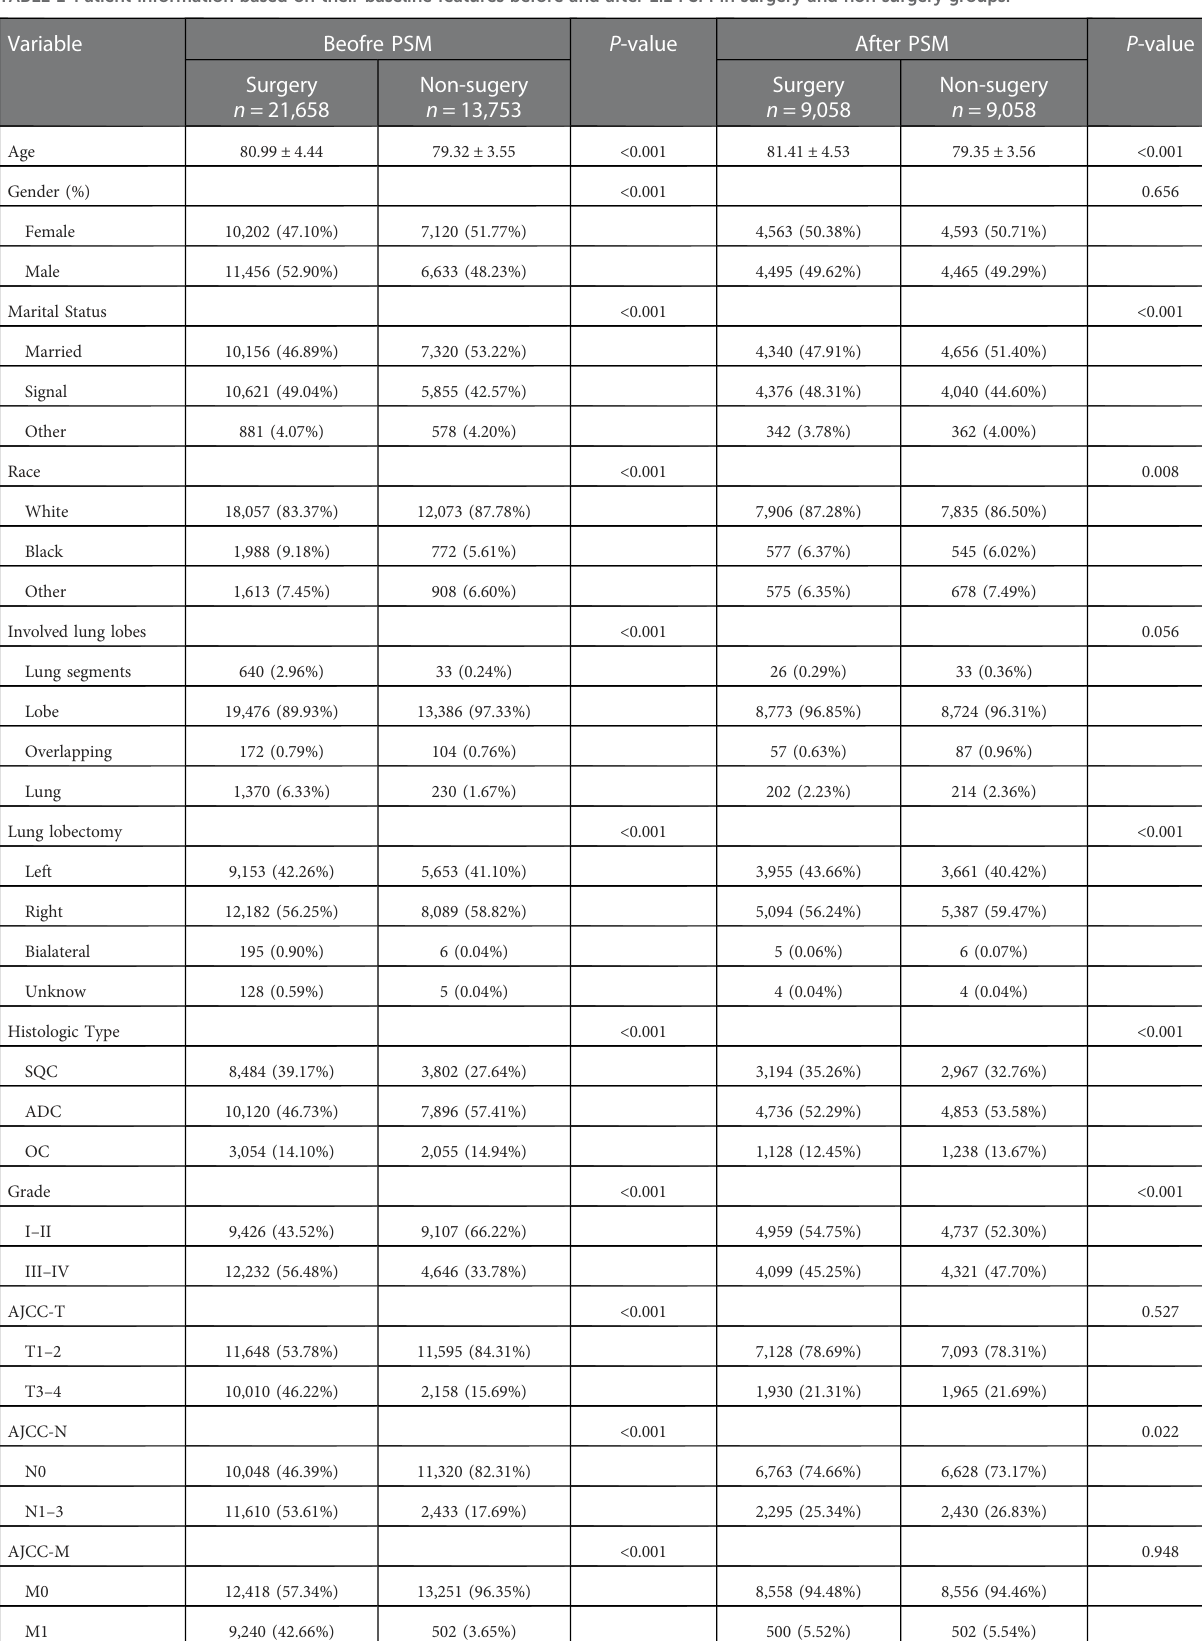
TABLE 1 Patient information based on their baseline features before and after 1:1 PSM in surgery and non surgery